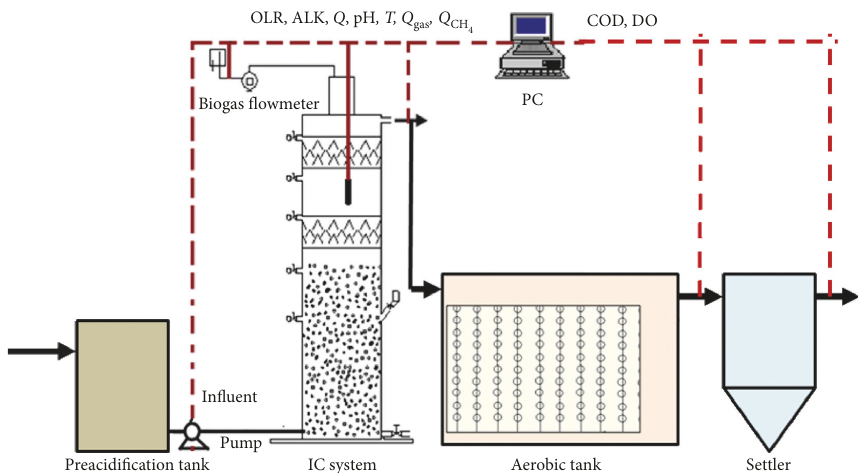
Figure 1: Schematic diagram of the full-scale anaerobic